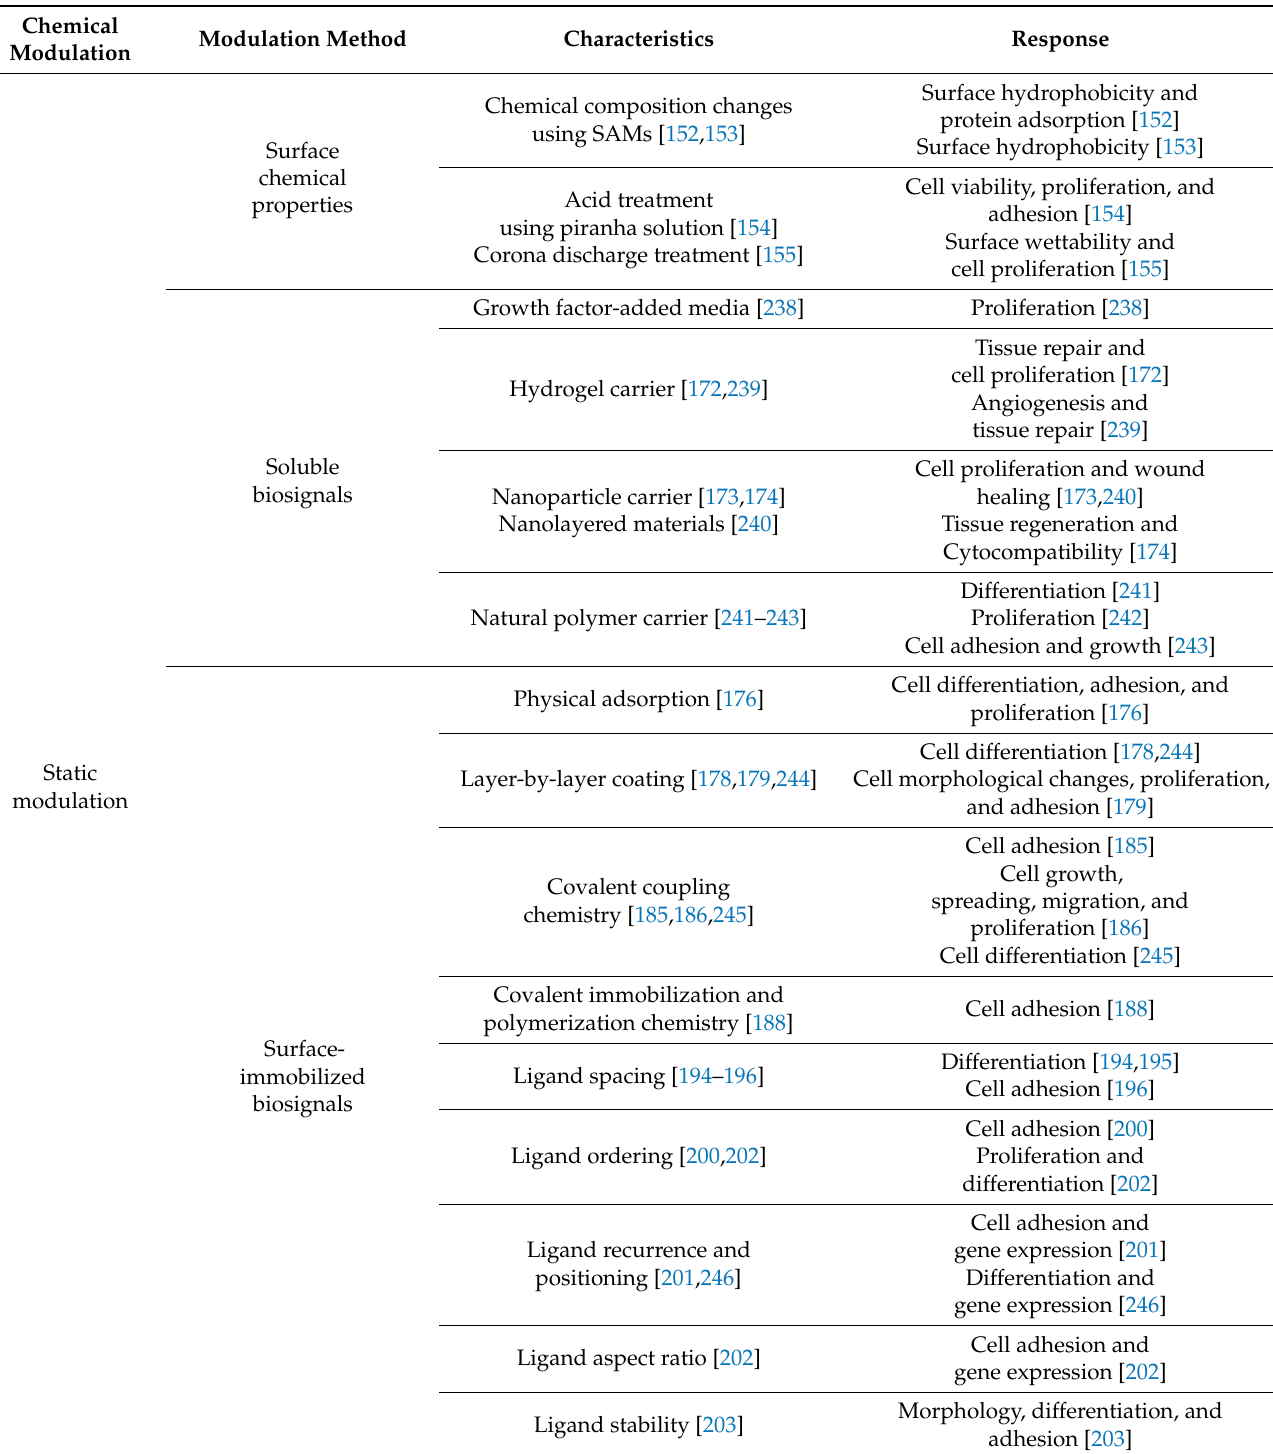
Table 2. Examples of chemical